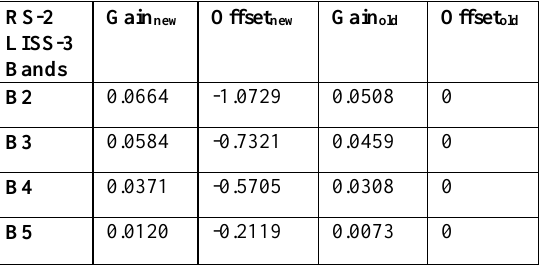
Table 3.New and old gain & offsets.